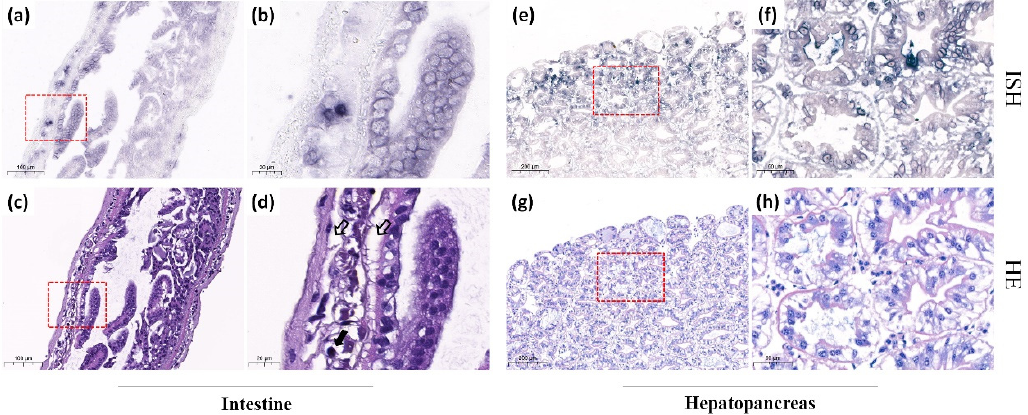
Figure 2. Micrographs of histopathological and in situ hybridization (ISH) assays for the intestine and hepatopancreas from Macrobrachium rosenbergii naturally infected by covert mortality nodavirus (CMNV). ( a ) ISH micrographs of intestine. ( b ) Magnified views of the red-framed areas of ( a ). Note the bluish-purple hybridization signals of CMNV probe. ( c ) H&E staining micrographs of intestine histological section. ( d ) Magnified views of the red-framed areas of ( c ). Karyopyknosis (thick black arrows) and extensive vacuolation (hollow arrows) were observed in the intestinal muscle layer. ( e ) ISH micrographs of hepatopancreas. ( f ) Magnified views of the red-framed areas of ( e ). Note the bluish-purple CMNV positive hybridization signals. ( g ) H&E staining micrographs of hepatopancreas histology section. ( h ) Magnified views of the red-framed areas of ( g ). Note the necrosis and slightly exfoliated hepatopancreatic tubular epithelium cells. Scale bars: ( a , c ) 100 µ m, ( b , d ) 20 µ m. ( e , g ) 200 µ m, ( f , h ) 50 µ m.